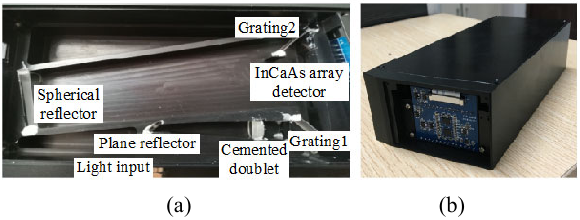
Fig. 5 Actual structure of the spectrometer: (a) optical structure and (b) side view of the